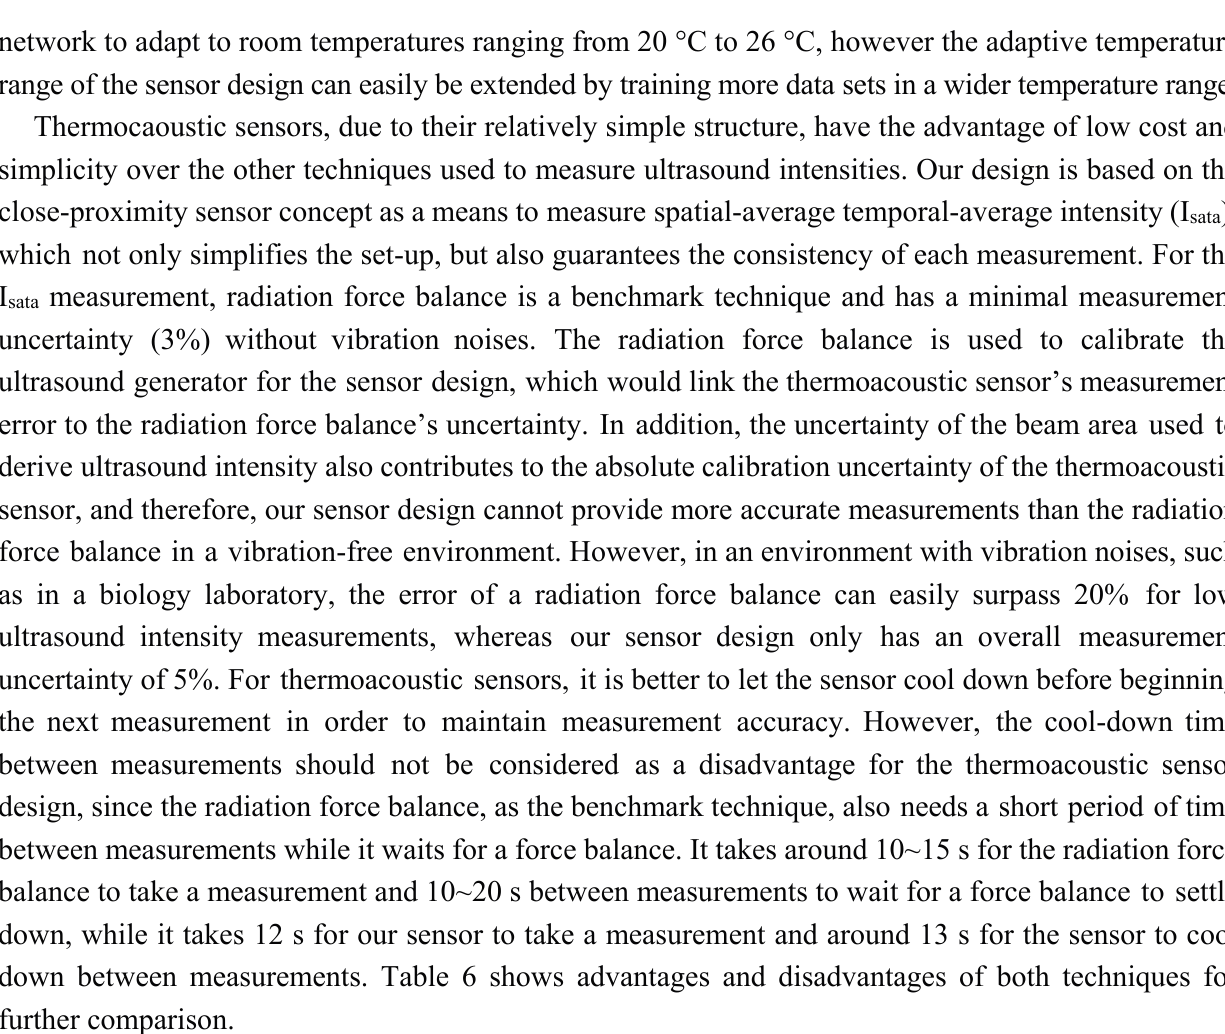
Table 6. Advantages and disadvantages of radiation force balance and the thermocaoustic sensor. Advantages Disadvantages Radiation Force Balance